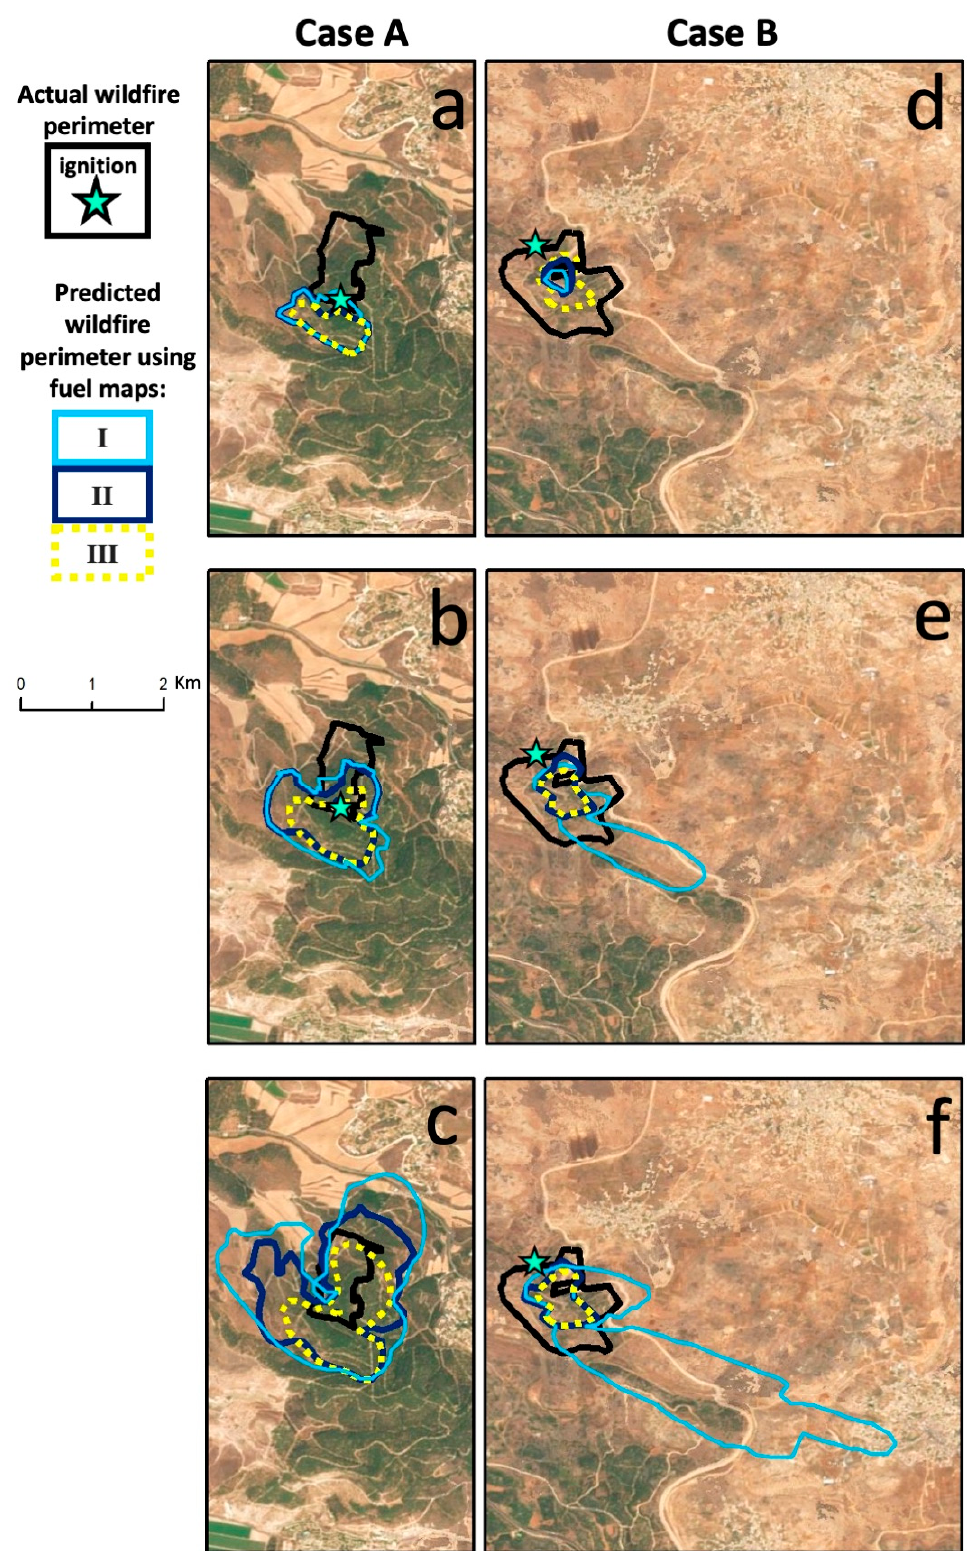
Figure A1. The WRF-Fire simulation results for the three fuel maps are shown for 9:00 ( a , d ), 10:00 ( b , e ), and 11:00 AM ( c , f ) local time.